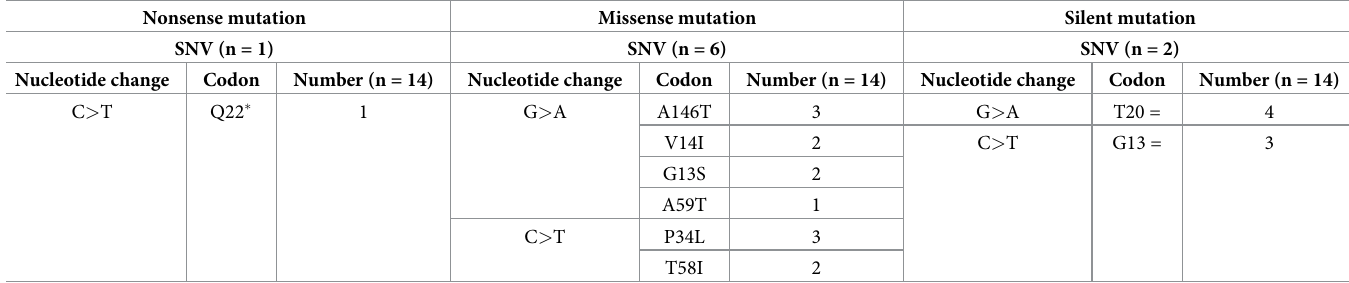
Table 5. KRAS mutation.